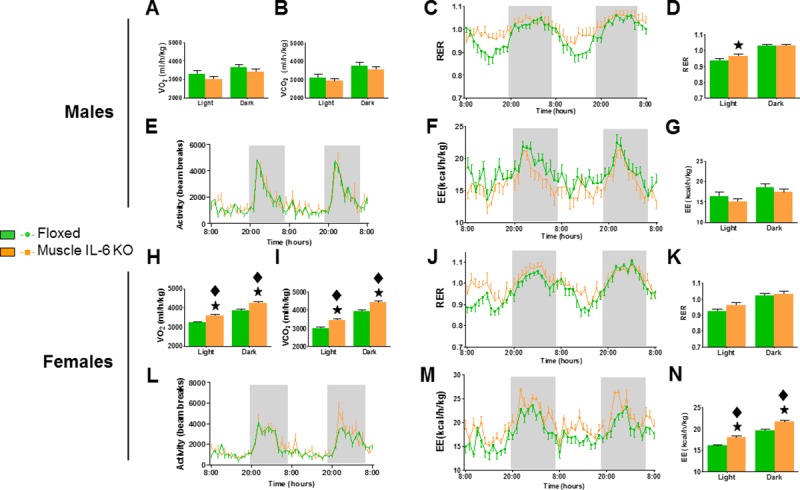
Indirect calorimetry measures of resting conditions (48 h).VO2, VCO2, RER, activity and EE means during the light and dark phase are shown in full and/or summarized as bar graphs. Muscle IL-6 deficiency in males (n = 7) results in significantly higher RER in the light phase (C, D) although no differences with floxed mice (n = 8) were noted in VO2 (A), VCO2, (B), activity (E) and EE (F, G). In females, significant differences between muscle IL-6 KO (n = 8) and floxed (n = 8) mice were noted in VO2 (H), VCO2 (I) and EE (M, N), but not in RER (J, K) and activity (L). ★ p at least < 0.05 versus floxed mice. ◆ p at least < 0.05 versus male mice.